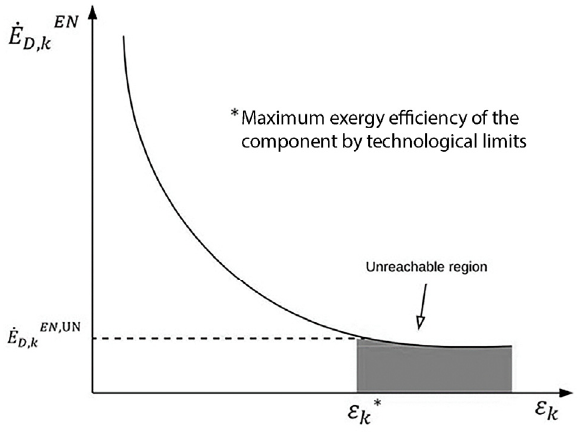
Figure 3. Endogenous curve by the graphic method.